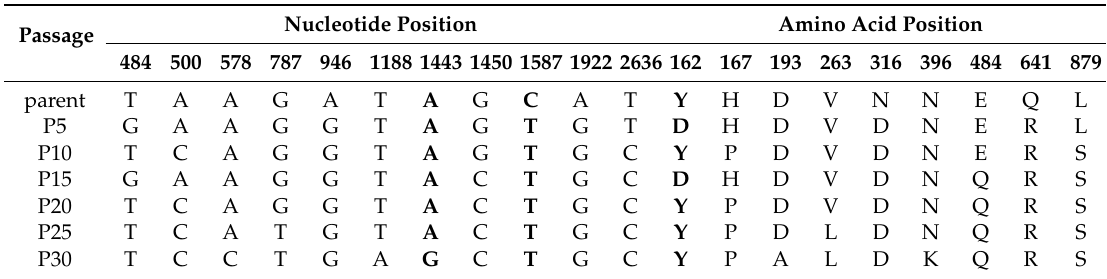
Table 2. Sequence variation analysis of the S gene during serial passage.